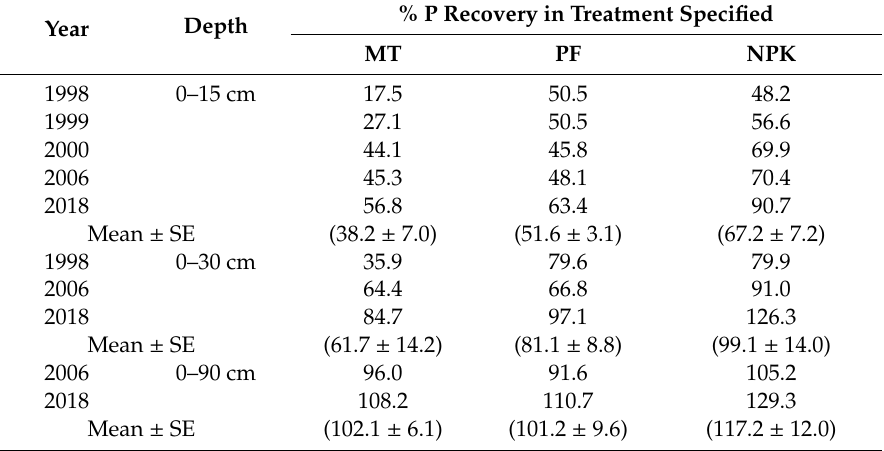
Table 4. Recovery (%) of added P calculated based on input and output by sampling year, soil depth, and